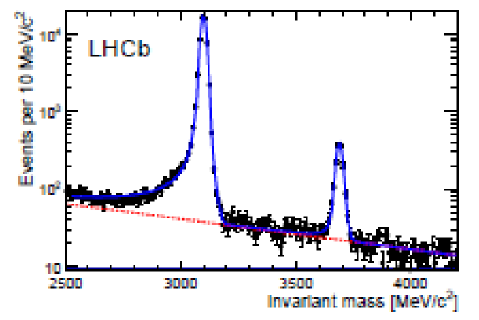
Figure 3. Mass spectrum of exclusively produced dimuons (taken from Ref.